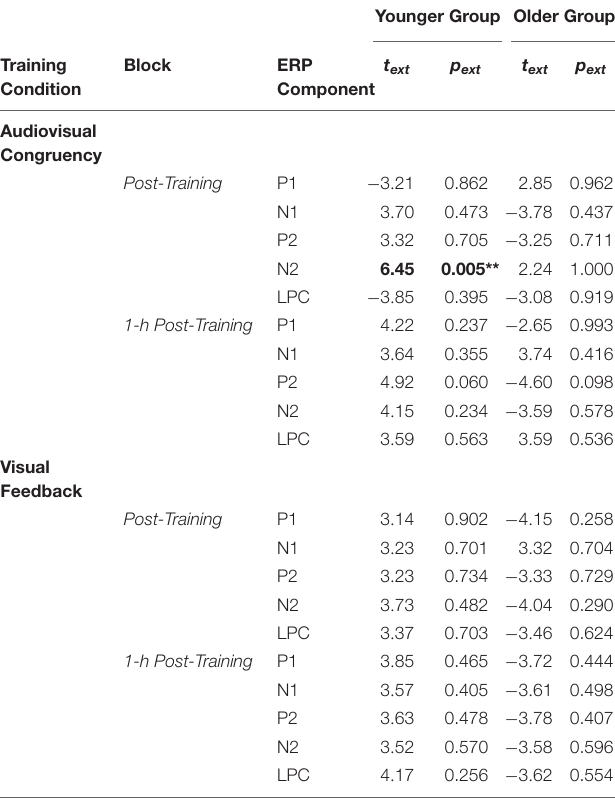
TABLE 2 | Contrast of training vs. control conditions, as revealed by sLORETA. Younger Group Older